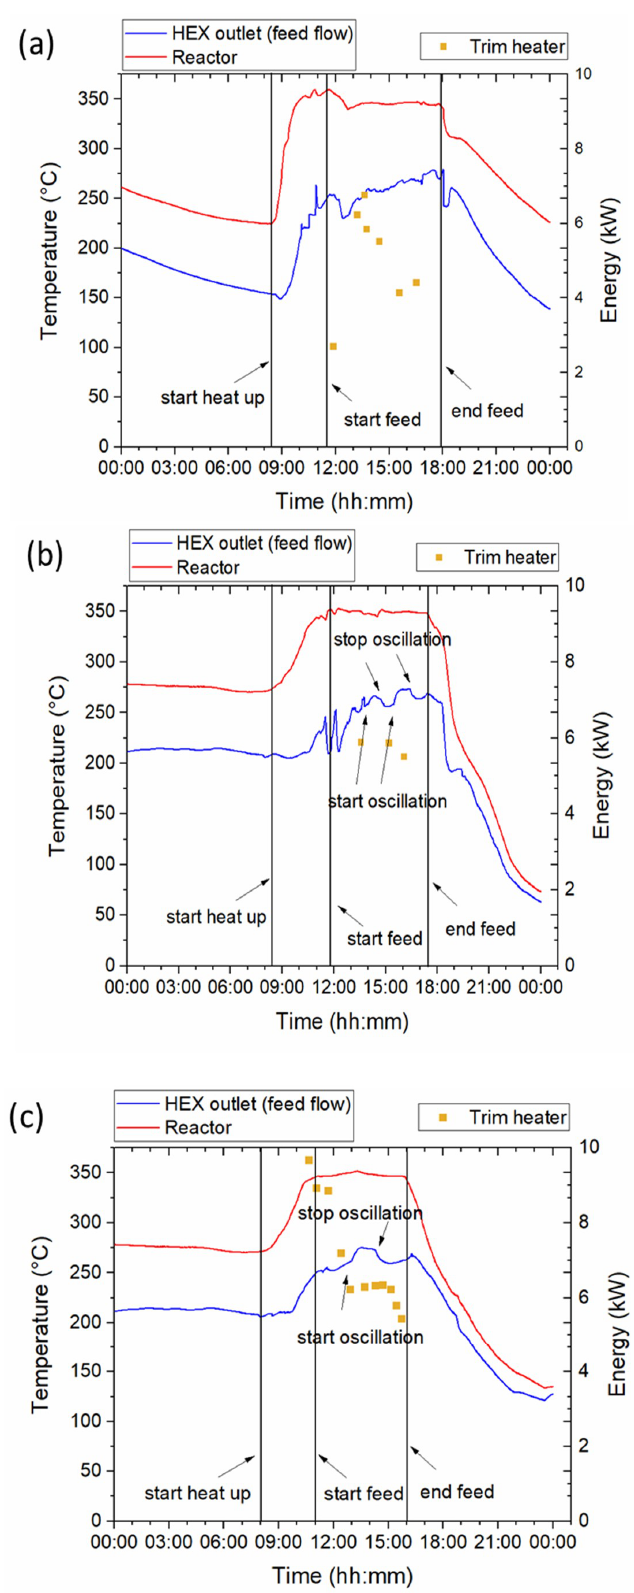
Figure 2. Temperature profiles at the heat exchanger outlet (feed flow) and inside the reactor and energy consumption by the trim heater at 220 bar for HTL runs of ( a ) Miscanthus , ( b ) Spirulina and ( c ) sewage sludge. Table 3. Heat recovery (HR %) by the heat exchanger for HTL runs of the three biomass feedstocks.